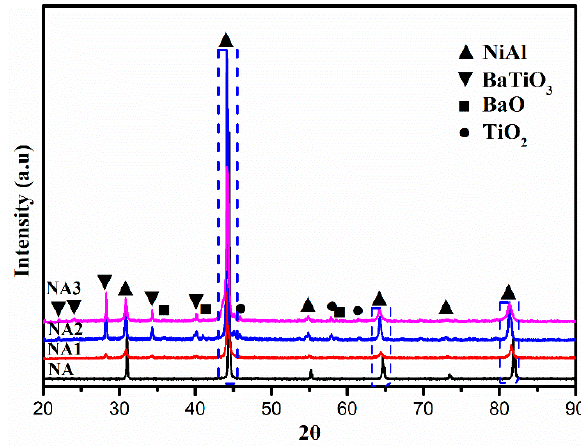
Figure 2. XRD patterns of the composites.